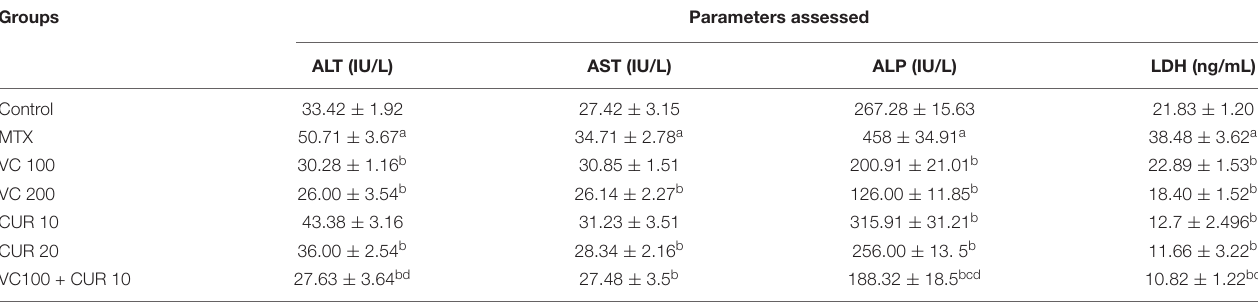
TABLE 1 | Changes in serum liver enzyme between mice treated with MTX, vitamin C, and curcumin alone and in combination (pretreatment groups).